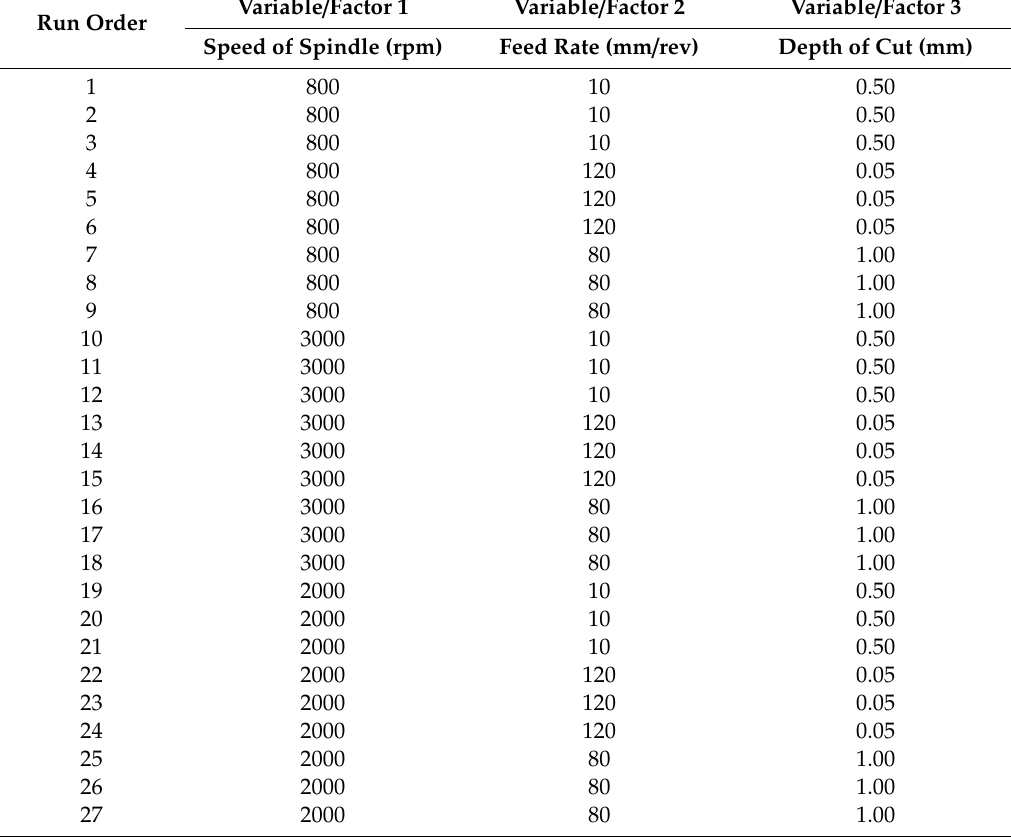
Table A1. Experiments obtained from Taguchi optimization